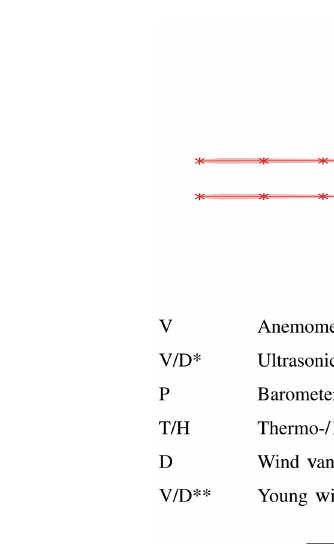
In the analysis presented here, only results from a horizon- tal line scan are analyzed, so that no vertical meandering is eliminated from the wind speed deficit, and the deficit’s depth is less pronounced in comparison to the real MFR. To clarify that the vertical meandering is not eliminated in the present investigation, but included in the wind speed deficit, the abbreviation HMFR (horizontal meandering frame of ref- erence) is introduced and henceforth used instead of